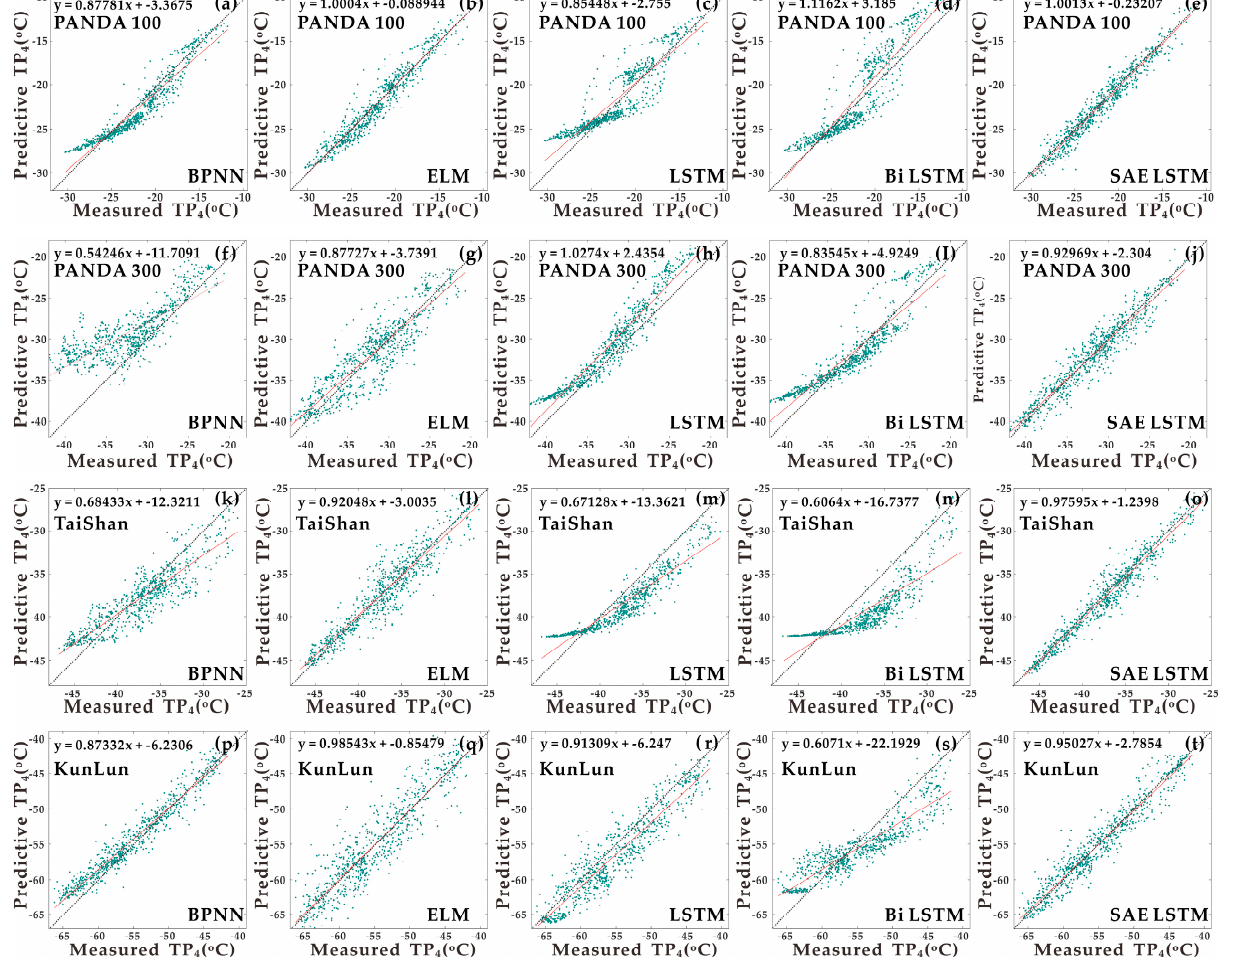
Figure 12. The results of a linear fit of the single-step predicted and actual values of temperature for the four stations of the five models: ( a – e ) represent the linear fit for the PANDA100 station; ( f – j ) represent the linear fit for the PANDA300 station; ( k – o ) represents the linear fit for the TaiShan station; ( p – t ) represent the linear fit for the Kunlun station.